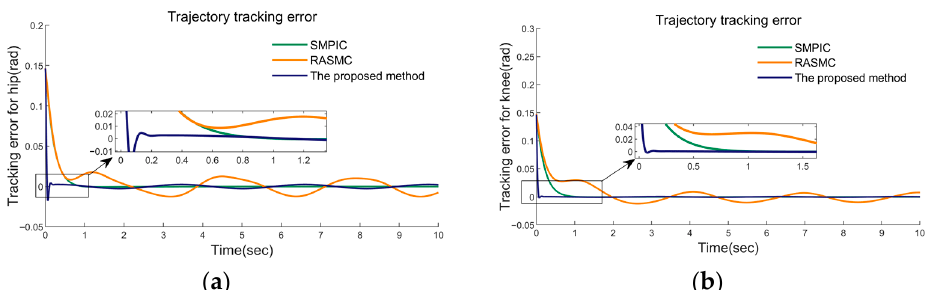
Figure 7. The tracking error of the joints. ( a ) the tracking error of θ 1 under case 0 condition; ( b ) the tracking error of θ 2 under case 0